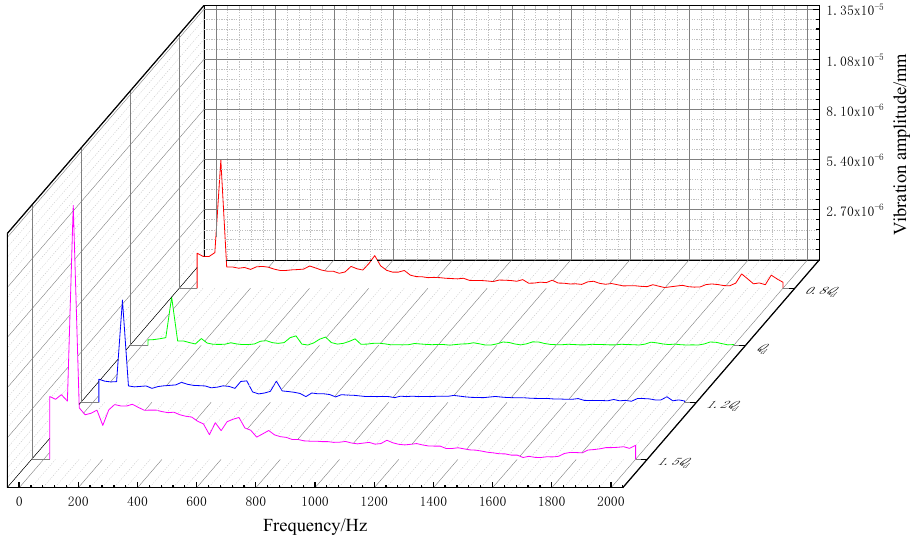
Figure 13. Impeller amplitude frequency diagram under different working conditions.